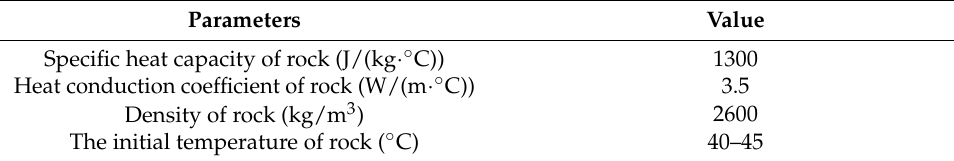
Table 1. Thermal parameters of